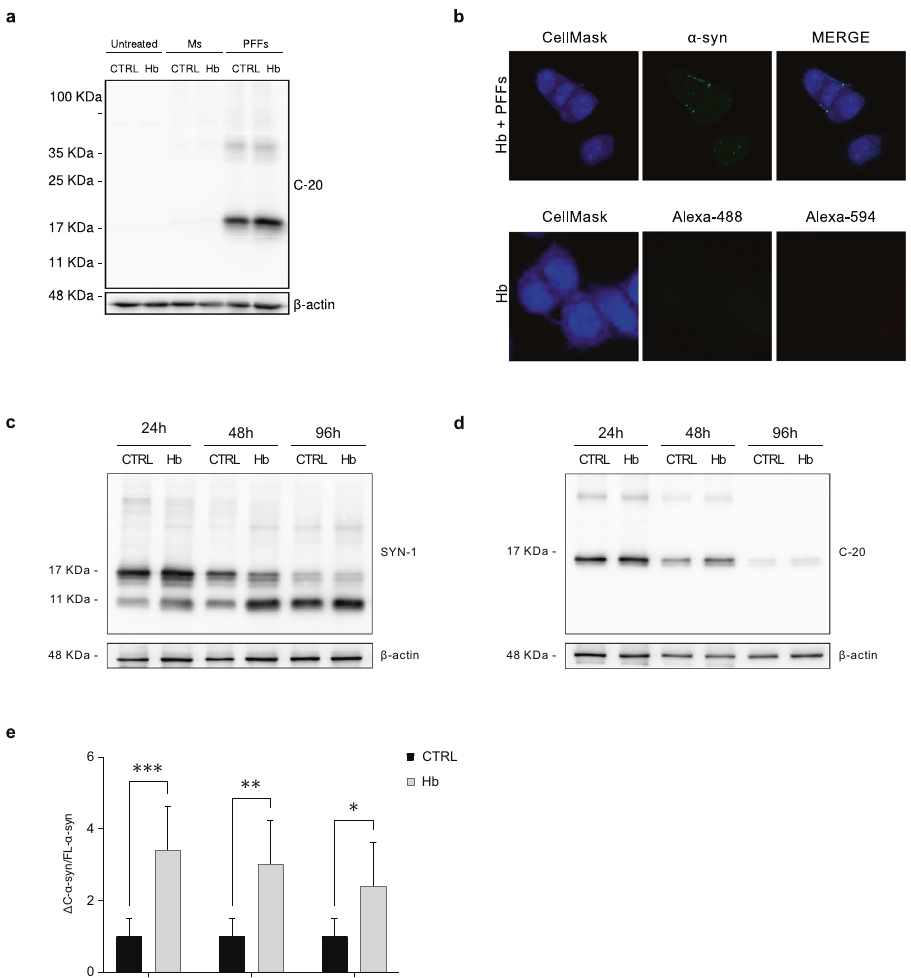
Fig. 4 Impact of Hb overexpression on the accumulation of C-terminal truncated α -syn. Representative Western blot of lysates from Hb and CTRL cells upon supplementation of vehicle, Ms and PFFs for 24 h ( a ). Representative confocal microscopy images of Hb cells supplemented with Alexa-488 labelled PFFs for 24 h. Entire cells were labelled by CellMask. Untransfected cells incubated only with secondary antibody were used to establish auto fl uorescence levels. Nuclei were stained with DAPI. Scale bar 10 μ m ( b ). CTRL and Hb cells were treated with α -syn amyloids. Cell lysates were collected at the indicated time points and analyzed by immunoblotting with SYN-1 ( c) and C-20 antibodies ( d ). Band intensity corresponding to Δ C- α -syn and FL- α -syn was quanti fi ed and the ratio was calculated. Data represent means ± SEM and are representative of six independent experiments. Statistical analysis was performed with one-way Anova. * p ≤ 0.05; ** p ≤ 0.01; *** p ≤ 0.001 ( e